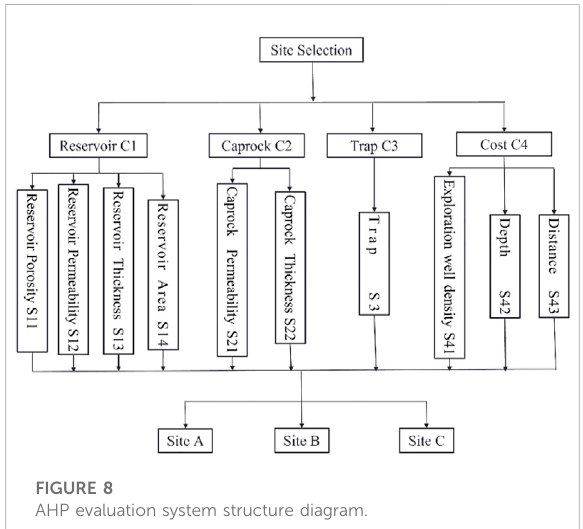
FIGURE 8 AHP evaluation system structure